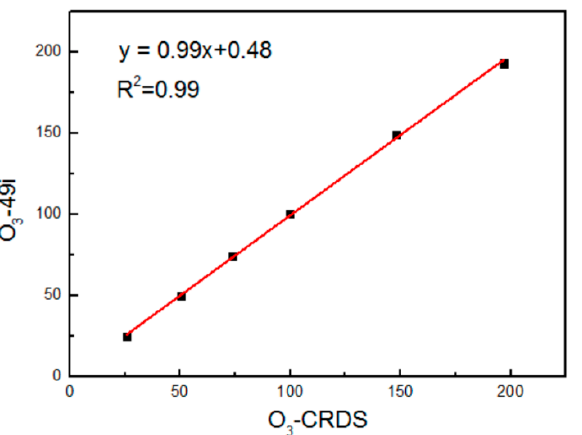
Figure 7. Correlation plot comparing O 3 measurements acquired by CRDS and the 49i ozone analyzer.